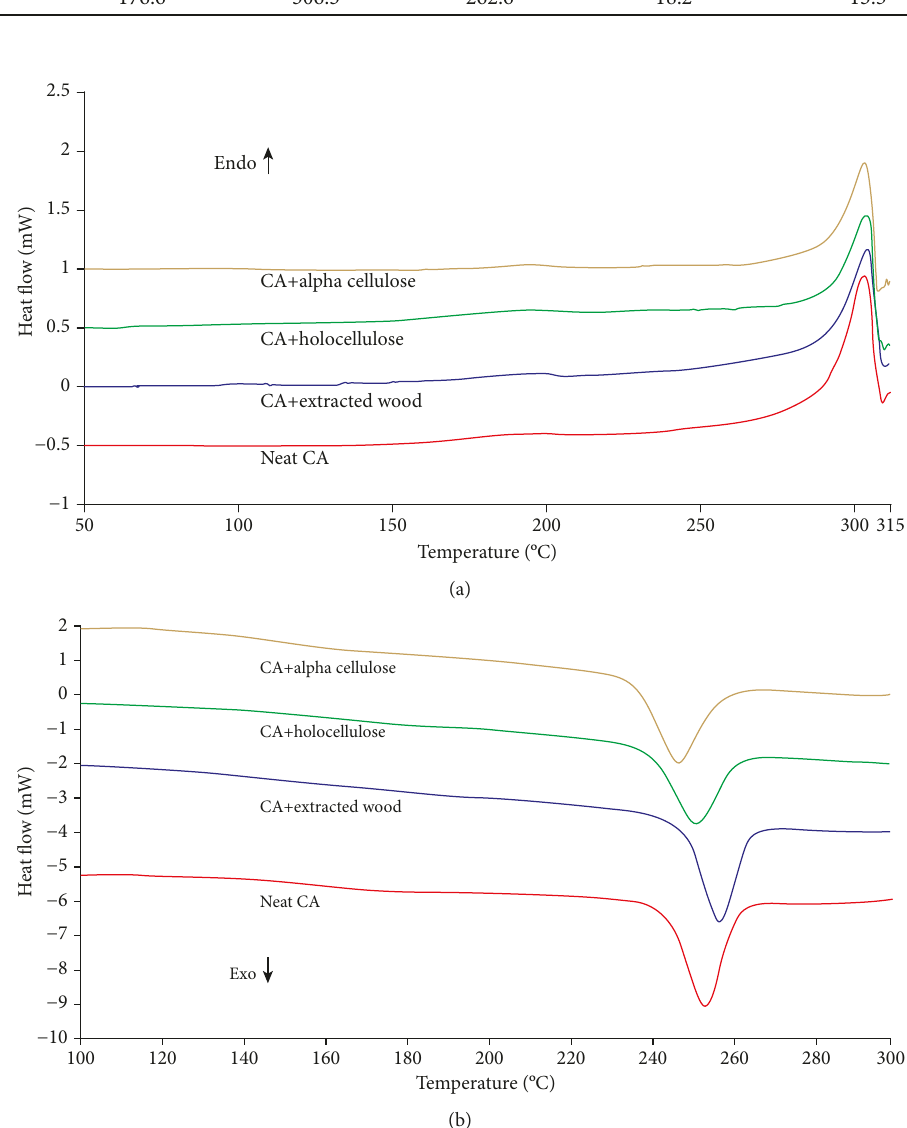
Figure 5: DSC curves of neat CA and biocomposites prepared from white willow: (a) heating endotherms; (b) cooling